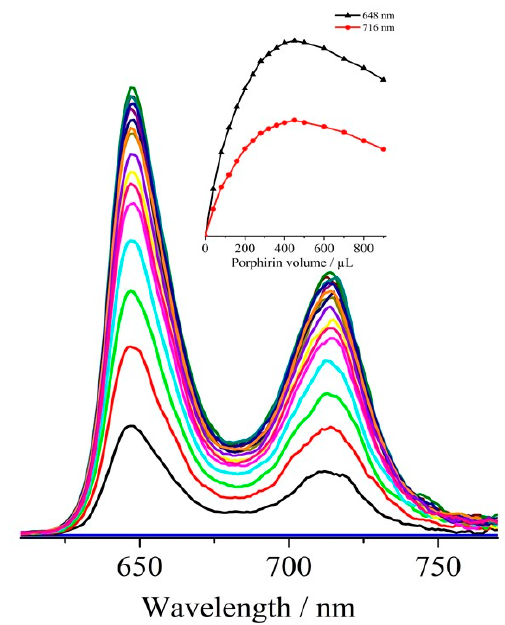
Figure 9. Fluorescence spectra ( λ ex = 410 nm) of 100 µL of an Au NPs aqueous 1.97 × 10 − 7 M solution diluted with 2 mL of CH 3 OH (blue line superimposed to the x -axis), 40 (black line), 80 (red line), 120 (green line), 160 (cyan line), 200 (magenta line), 240 (yellow line), 280 (dark yellow line), 320 (navy line), 360 (purple line), 400 (wine line), 450 (olive line), 500 (dark cyan line), 600 (royal line), 700 (orange line), 800 (violet line), and 900 (pink line) µL aliquots of a 2.07 × 10 − 5 M porphyrin CH 3 OH solution (final total volume 3 mL). All the spectra were corrected for the volume variation. Inset: intensity behavior of the emission maxima upon the porphyrin additions.